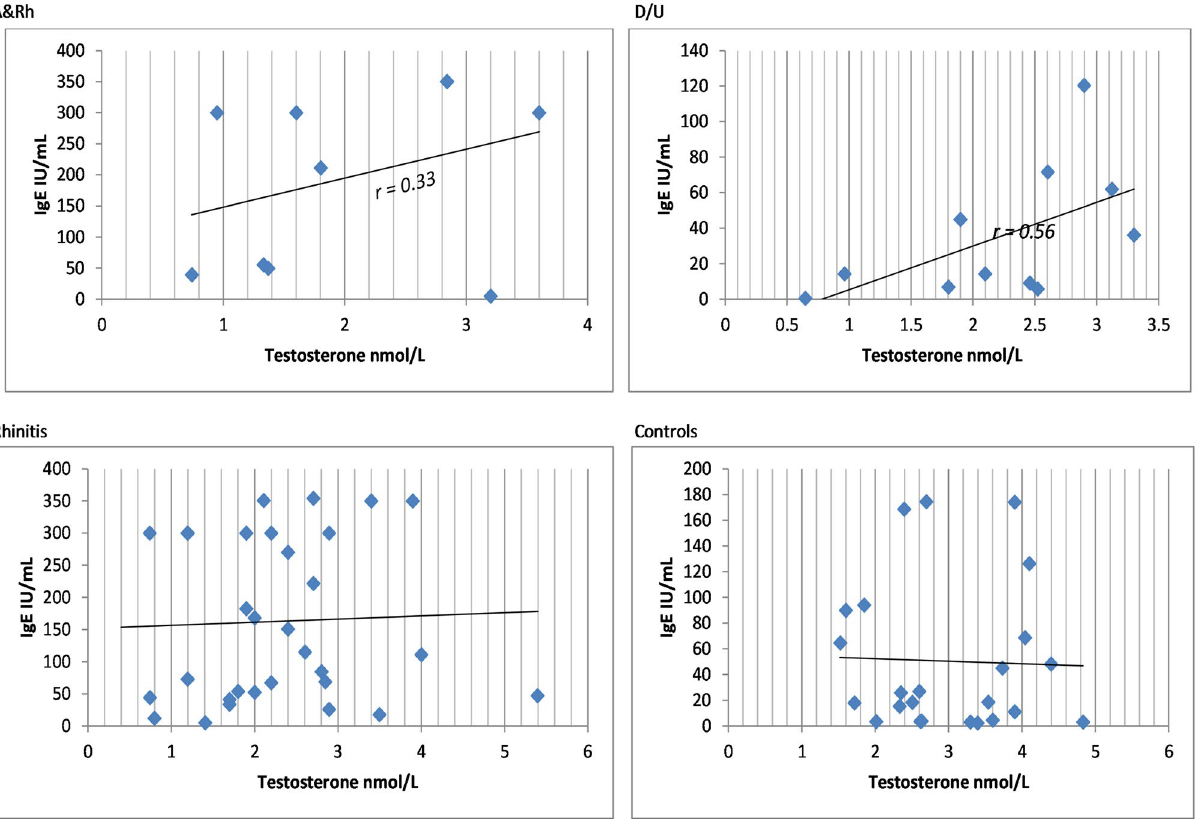
Figure 2. Positive correlation between total IgE levels and serum testosterone concentrations in female patients with allergies. IgE- immunoglobulin E; r —correlation